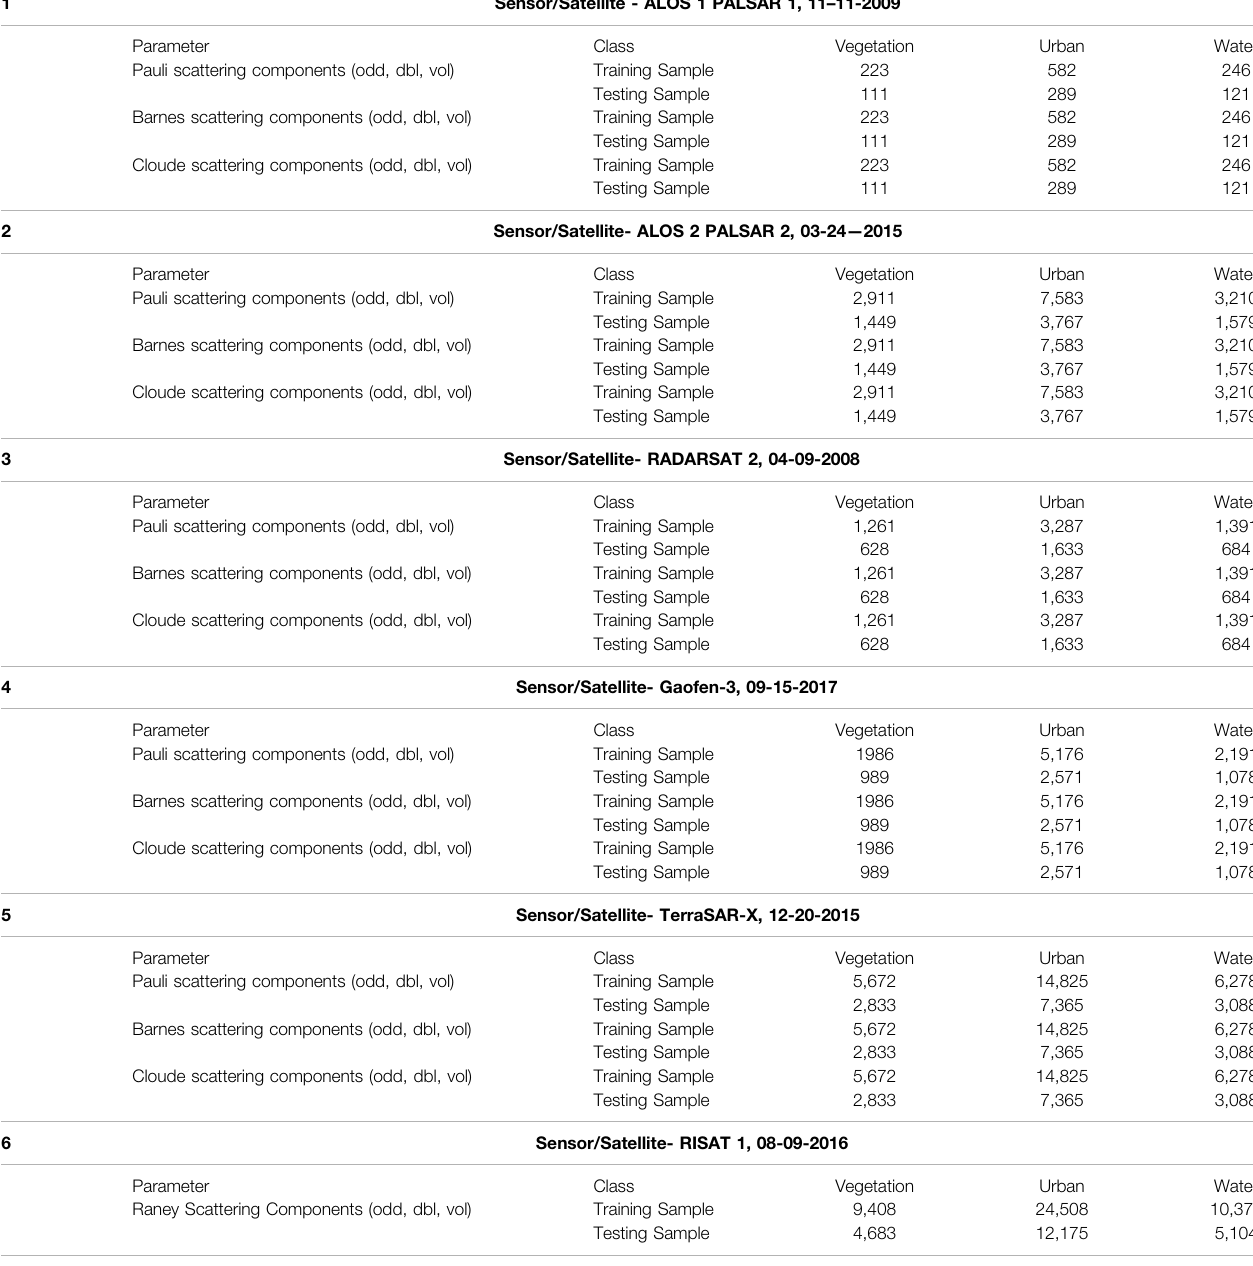
TABLE 2 | Description of training sample and testing sample used for SVM classi fi cation of surface (odd), double-bounce (dbl), and volume (vol) scattering components retrieved from decomposition models using multi-temporal and multifrequency